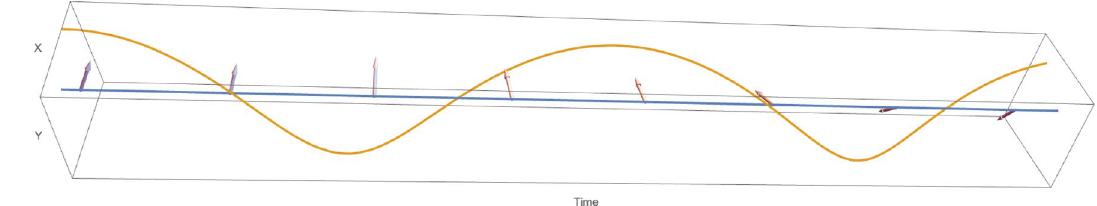
( t ) of the spin T carried along a point making a (cid:31) 3 c / 5 =